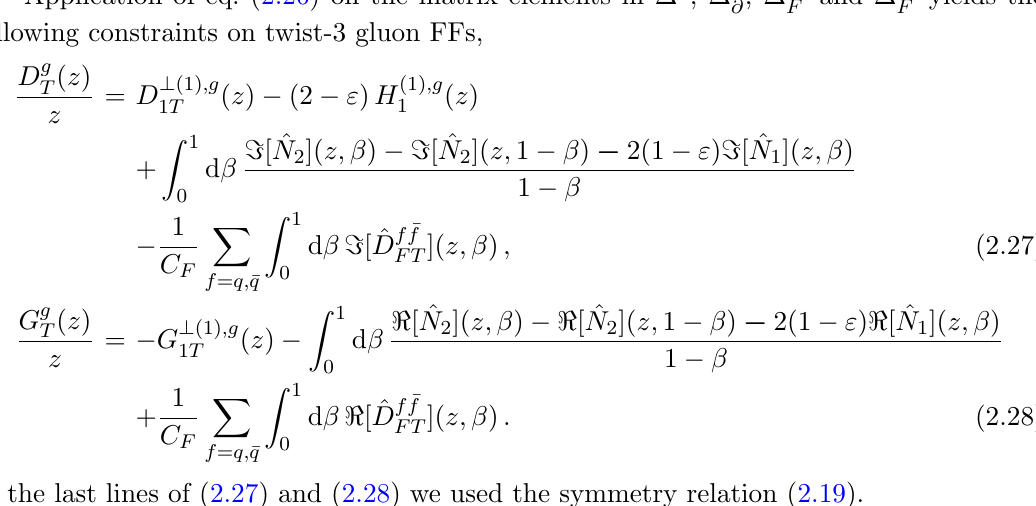
Figure 3. Fragmentation mechanism in e + e (cid:0) annihilation for intrinsic and kinematical